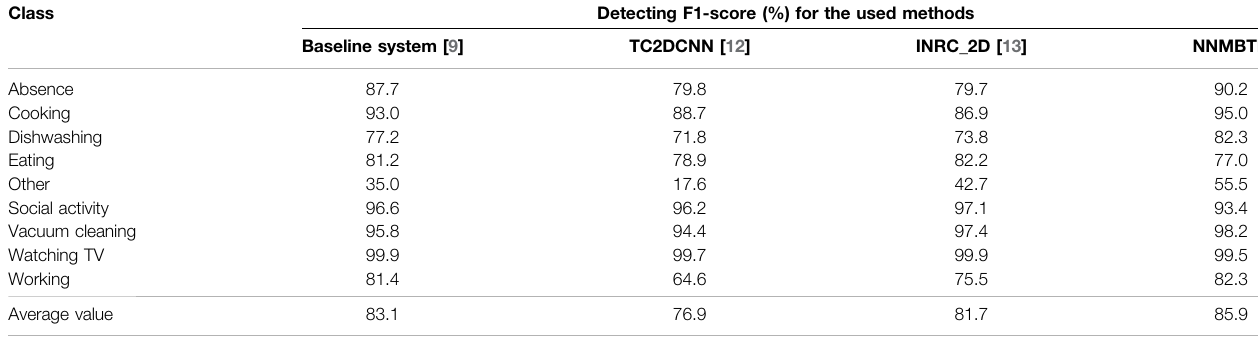
TABLE 3 | Comparison of the neural network model based on the tensor network with other models in the test set of the validation dataset. Class